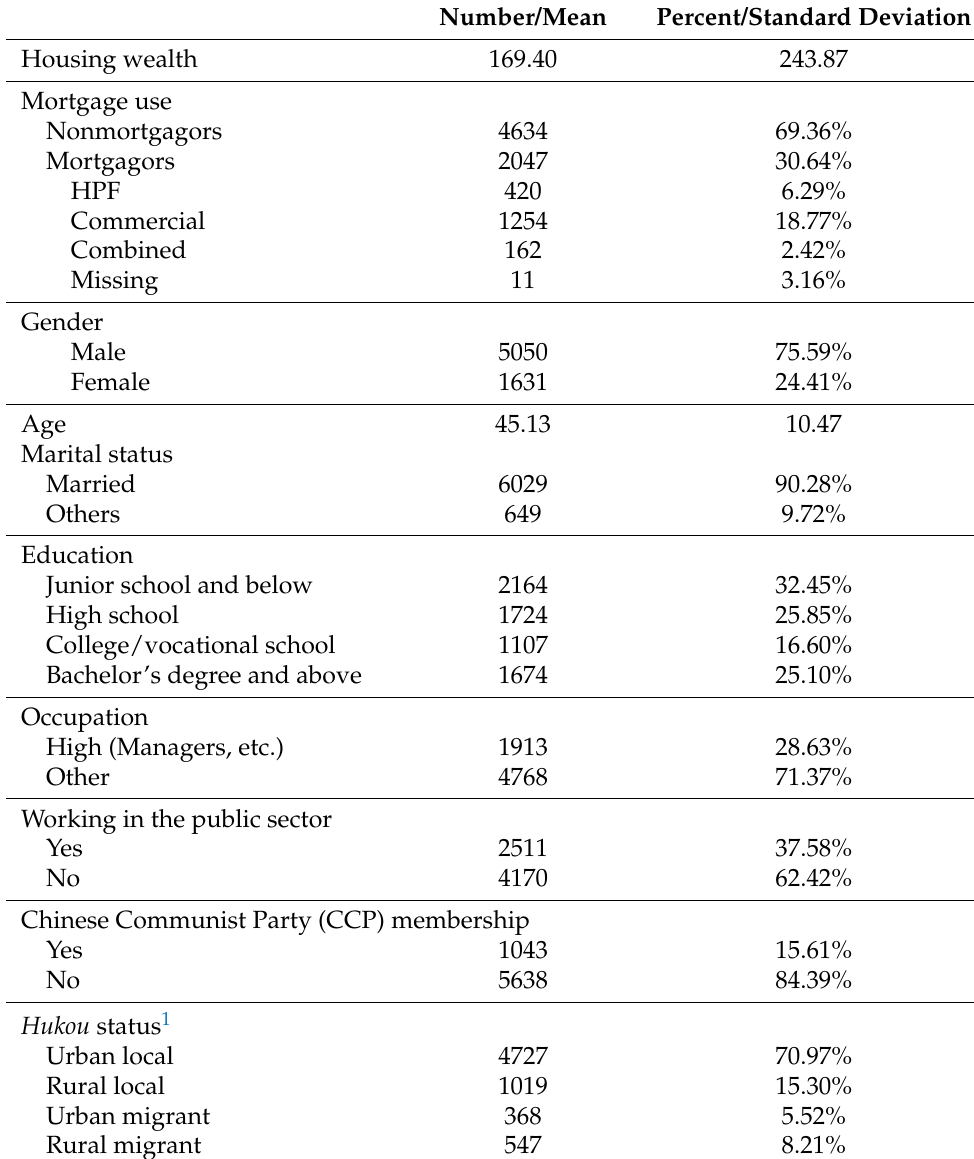
Table 1. The profile of samples ( n =